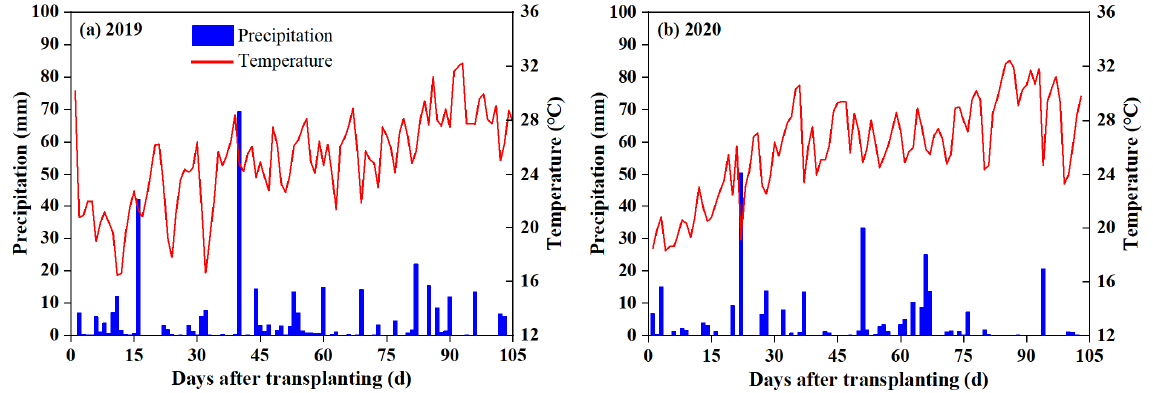
Figure 1. Daily mean temperature and precipitation during the pepper growing season in 2019 ( a ) and 2020 ( b ). ( a ) and 2020 ( b